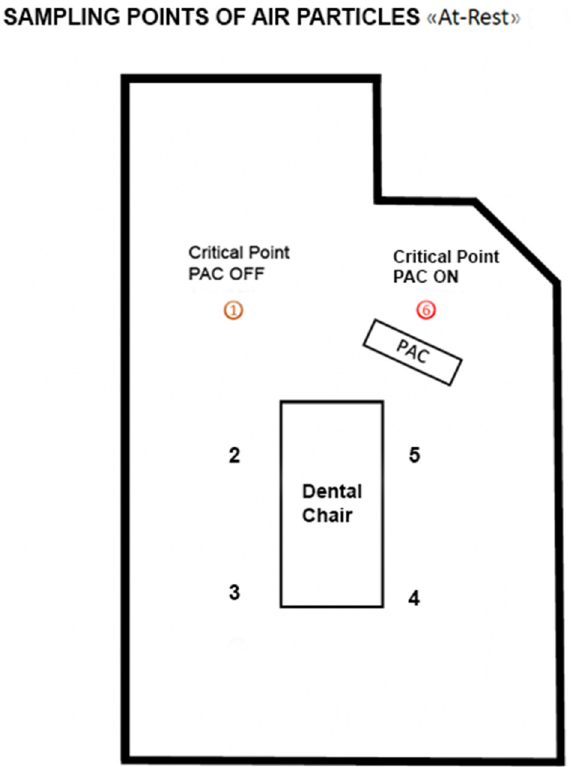
Figure 3. Planimetry of the experiment. PAC = Portable Air Cleaners, the 2 points in red (1 and 6) are the most critical points.